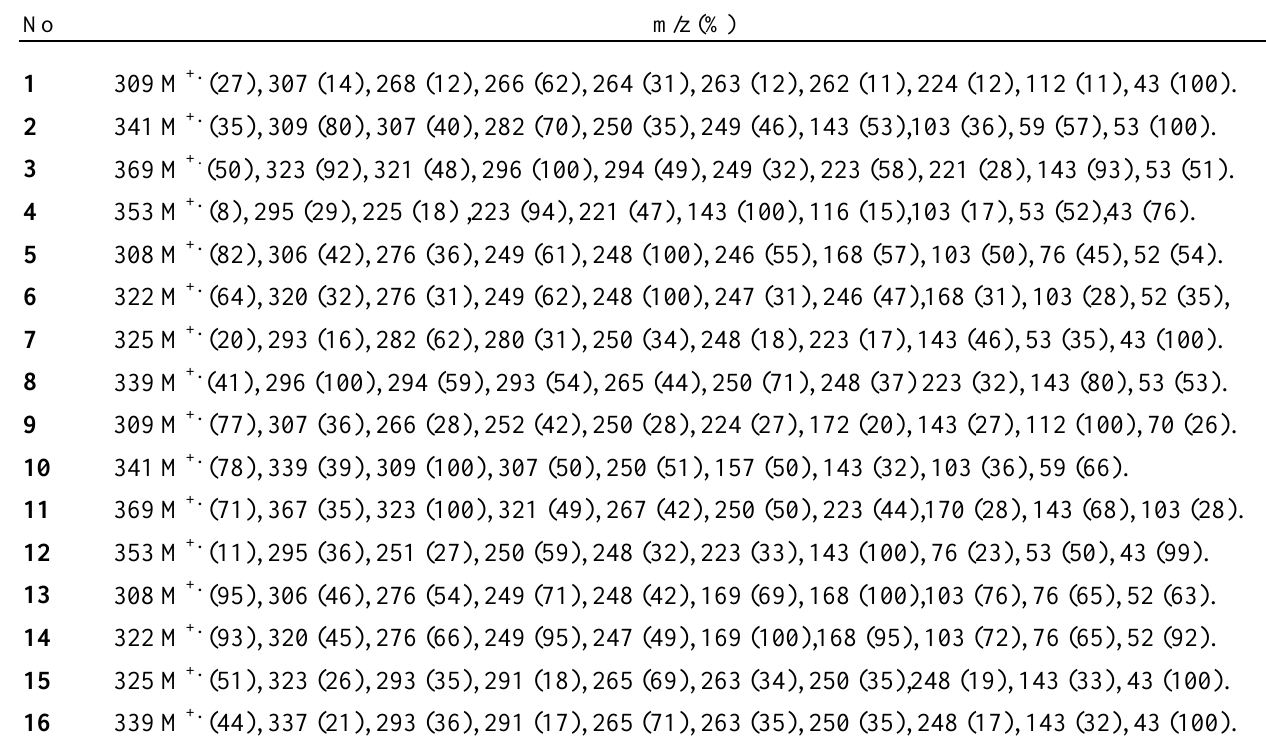
Table 2. EI mass spectra of 4- and 5-substituted derivatives of benzoselenadiazoles a,b .